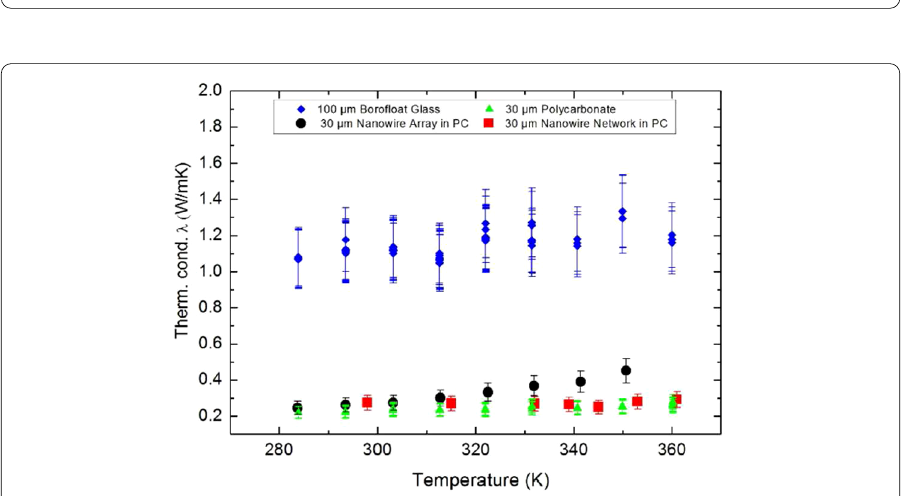
Figure 6 Relative electrical resistance and Seebeck coefficient of Sb nanowire networks with a nanwire density of 1.4 × 10 9 cm –2 and various wire diameters as a function of temperature. From M.F.P. Wagner, PhD Thesis, Technische Universität Darmstadt, 2018